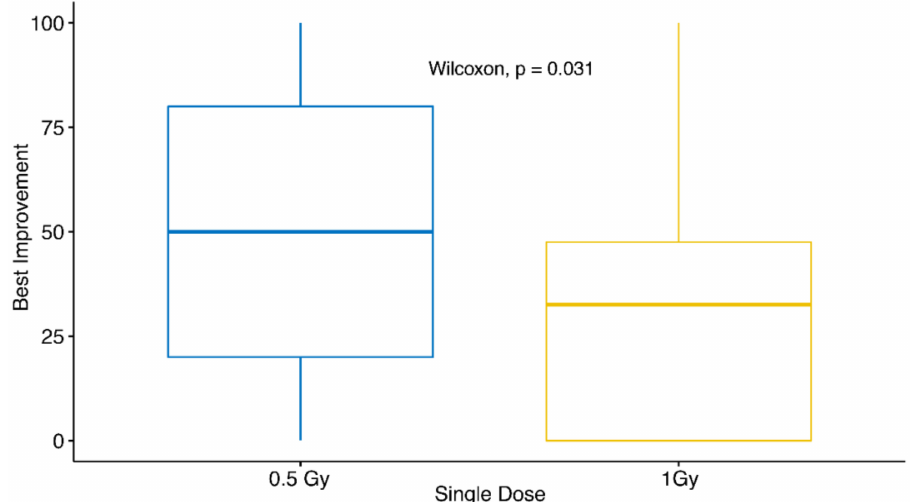
Figure 4. Therapeutic success in dependence of the applied single dose of LDRT. The Wilcoxon Test was applied to compare the best improvement of patients in dependence of the single dose per fraction (0.5 Gy or 1.0 Gy) of LDRT. Here, the best percentage of improvement achieved was applied for the test independent of the time point of data